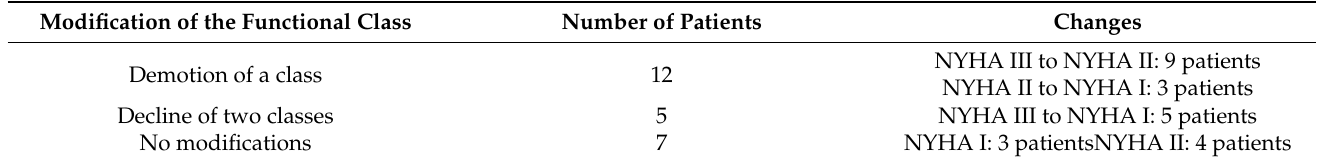
Table 3. Variations of NYHA in patients following the addition of SGLT2